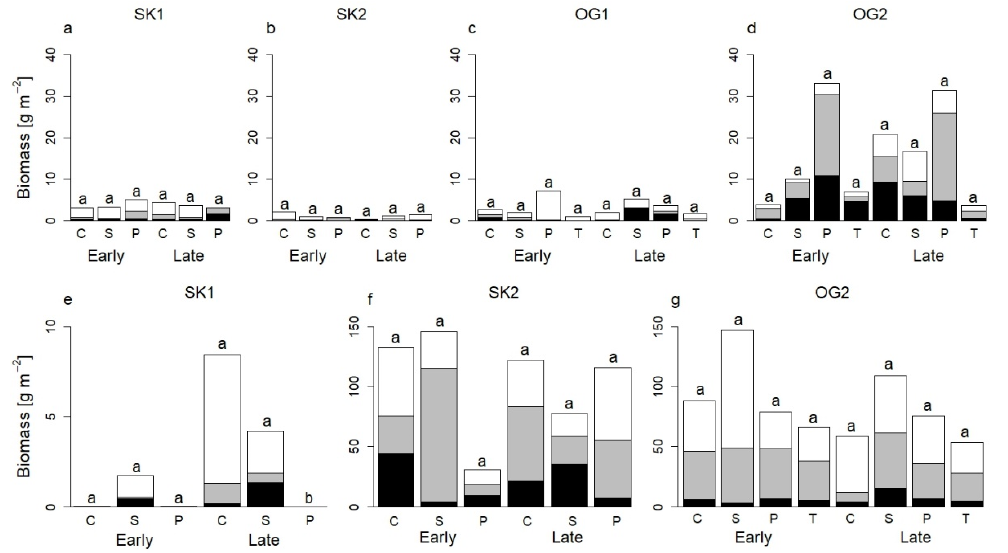
Figure 8. Weed biomass in oats ( a – d ) and winter wheat ( e – g ) before cash crop harvest. Biomass values are back-transformed from log-transformed model estimates. Abbreviations: SK and OG stands for the two experimental regions, 1 = starting 2017, 2 = starting 2018, SC = service crop, S = frost-sensitive annuals, P = perennials, T = frost-tolerant annuals. No data are presented for winter wheat in the OG1 experiment since spring wheat was grown here this year. The colour coding shows the biomass in the different subsections of the sampled areas: white = in crop row, grey = close to crop row, black = inter-row centres. The letters indicate significant differences in total biomass, error bars for the 95% CI were not included in the figure since the wide CIs made the mean values and proportions difficult to read. Confidence intervals can be found in Table S3.4. See Section 2 for detailed treatment explanations and Table 1 for treatment overview. Observe that y-axis values differ between crops, and that of SK1 in winter wheat differs from the two others.